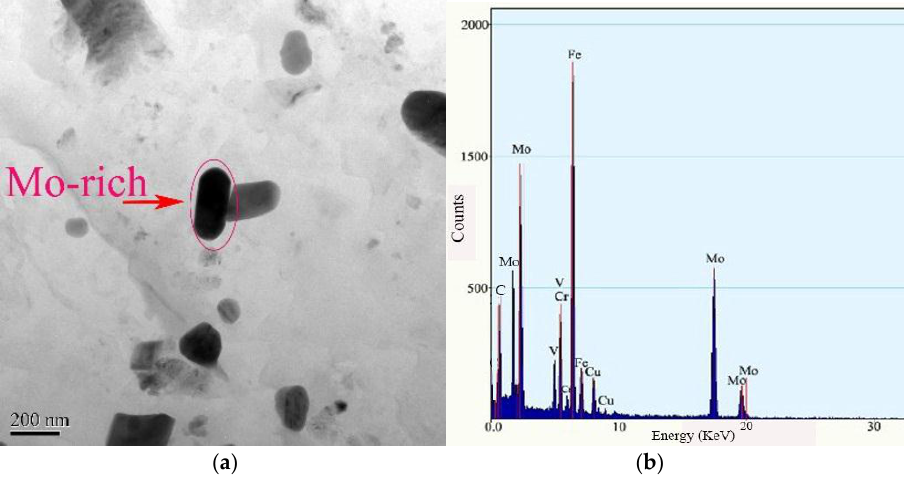
Figure 5. Precipitates of Mo-rich carbides at half-radius of the H13 ingot after tempering: ( a ) Morphology by TEM; ( b ) EDS analysis.